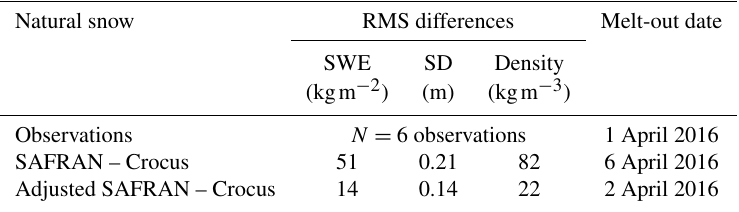
Table 6. Performance of the snowpack model in simulating the natural snow conditions before and after the adjusting of the meteorological forcing data and impurities rate (Sect. 2.4) quantified by the RMS of differences between model and